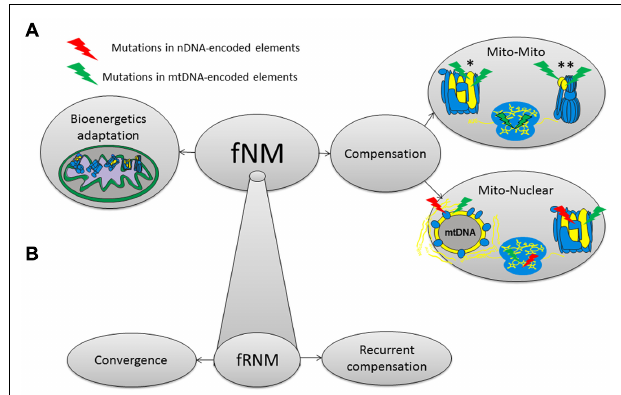
FIGURE 3 |A model summarizing mechanisms underlying the long term evolutionary survival of functional nodal mutations (fNMs). (A) fNMs, functional nodal mutations. *The compensatory mutation and the fNM occurred within the same mtDNA encoded component. **The compensatory mutation and the fNM occurred on different mtDNA encoded components. (B) Possible mechanisms underlying the long term evolutionary survival of functional recurrent nodal mutations